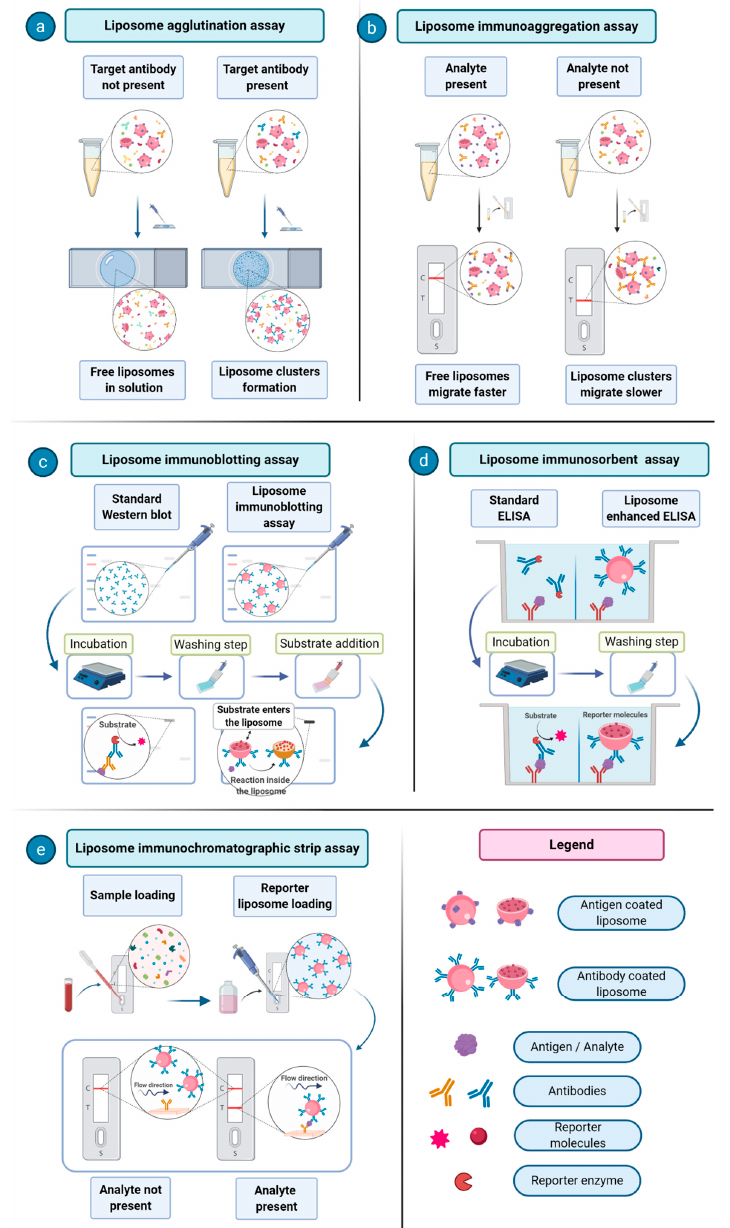
Figure 3. Examples of immunoliposome-involving assays. ( a ) Liposome agglutination assay: (left) liposomes do not aggregate in the absence of sample antibodies (Abs); (right) in the presence of multivalent Abs, liposomes form clusters which are visible by optical microscopy. ( b ) Liposome immunoaggregation assay: (left) in the presence of the analyte, Abs are not able to cluster liposomes into aggregates, leading to their fast migration; (right) Abs interact directly with the liposomes due to the absence of the analyte. ( c ) Liposome immunoblotting assay: protein antigens (Ags), previously separated by Western blot protocol, are probed with Ab-tagged enzyme-encapsulating liposomes. A substrate soluble into the lipid bilayer is used to obtain improved sensitivity over common enzyme Ab-conjugated reporter molecule. ( d ) Liposome immunosorbent assay: liposomes are used in the common ELISA protocol setting as signal amplifiers, compared to Abs conjugated with single reporter molecules. ( e ) Liposome immunochromatographic strip assay: liposomes are able to interact with an analyte previously captured by a primary Ab immobilized on a solid support, yielding a strong signal per analyte